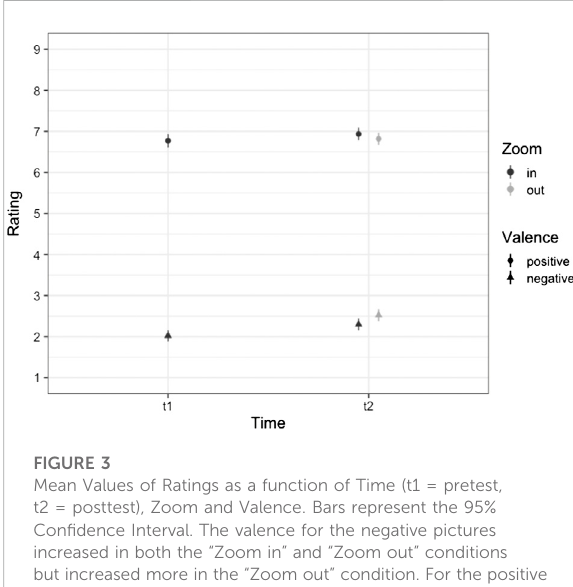
FIGURE 2 Mean Values of Valence Change as a function of Zoom and Valence. Bars represent the 95% Con fi dence Interval. The “ Zoom in ” condition led to a positive valence change of ~0.3 for the negative pictures and a positive valence change of ~0.15 for positive pictures, while the “ Zoom out ” condition resulted in an increase inpositive valence of0.4 for negative picturesand almost no change for positive pictures.